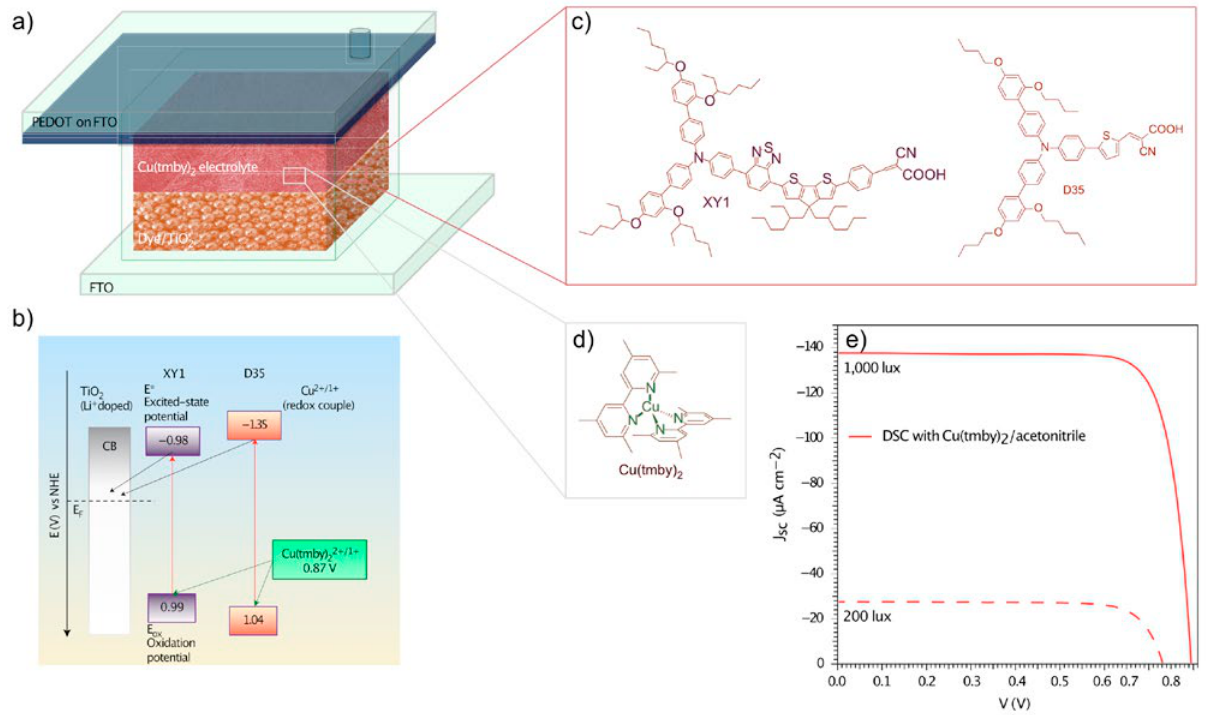
Figure 7. Example of a Cu-based dye-sensitized solar cell. (a) Schematic representation of the device architecture and (b) energy alignment of the device components, with the structure of the corresponding (c) dyes and (d) redox shuttle, as well as the (e) current-voltage charac- teristic at different light intensities. Adapted from ref. 47 with permission. tmby = 4,4’,6,6’-tetramethyl-2,2’-bipyridine; PEDOT = poly(3,4- ethylenedioxythiophene); FTO = fluorine-doped tin